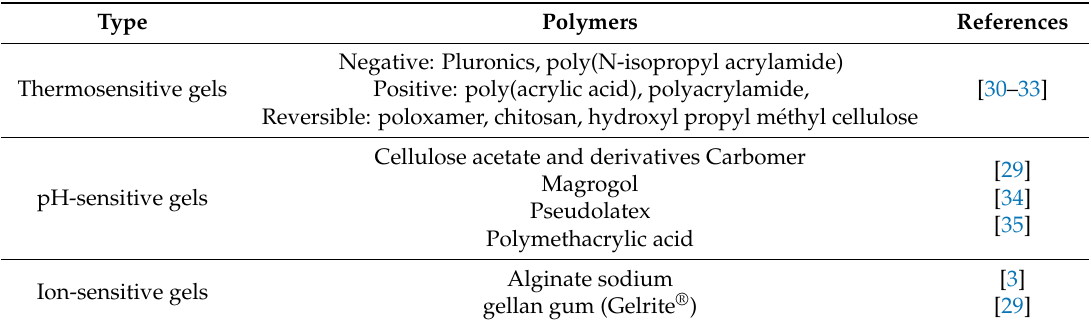
Table 1. Examples of thermosensitive, pH-sensitive and ion-sensitive polymers used for ophthalmic hydrogel